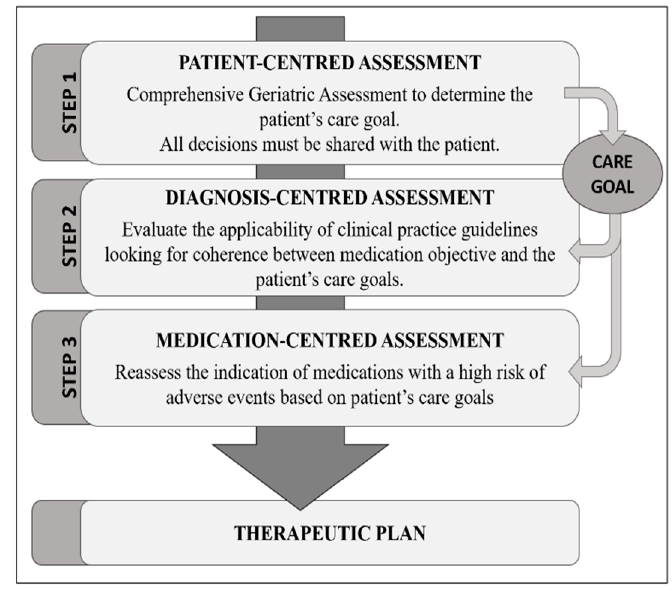
Figure 1. Patient-Centred Prescription (PCP) model.